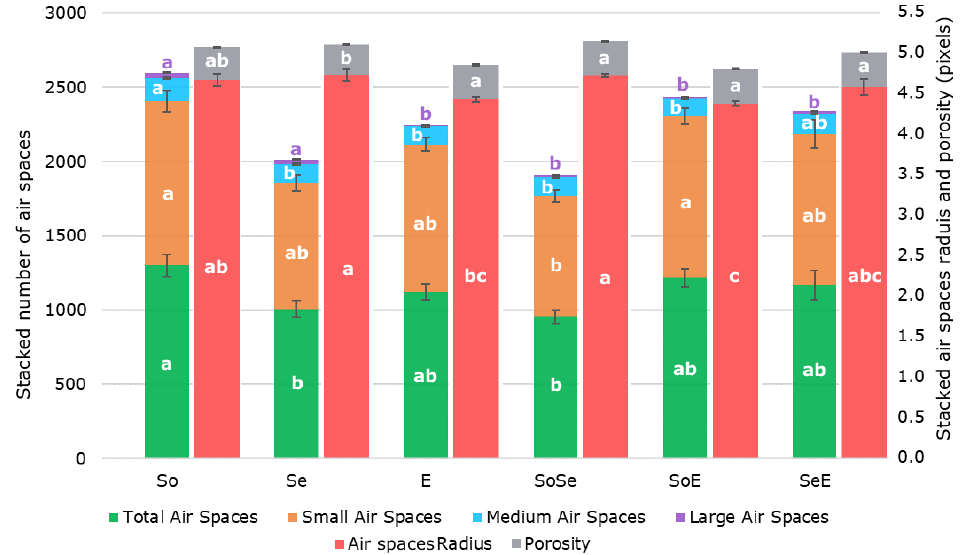
Figure 6. Stacked graph showing the mean values of the number of air spaces assessed from images of bread slices (Figure 2; primary y-axis; green, orange, blue, and purple bars) and the air space radius and porosity (secondary y-axis; red and gray bars). Different letters a–c depict significant differences between samples based on the ANOVA and Tukey’s honest significant difference (HSD) post hoc test (α = 0.05). Abbreviations: So: soft wheat; Se: semola; E: Emmer wheat; SoSe: soft wheat and semola; SoE: soft and Emmer wheat; SeE: semola and Emmer wheat.